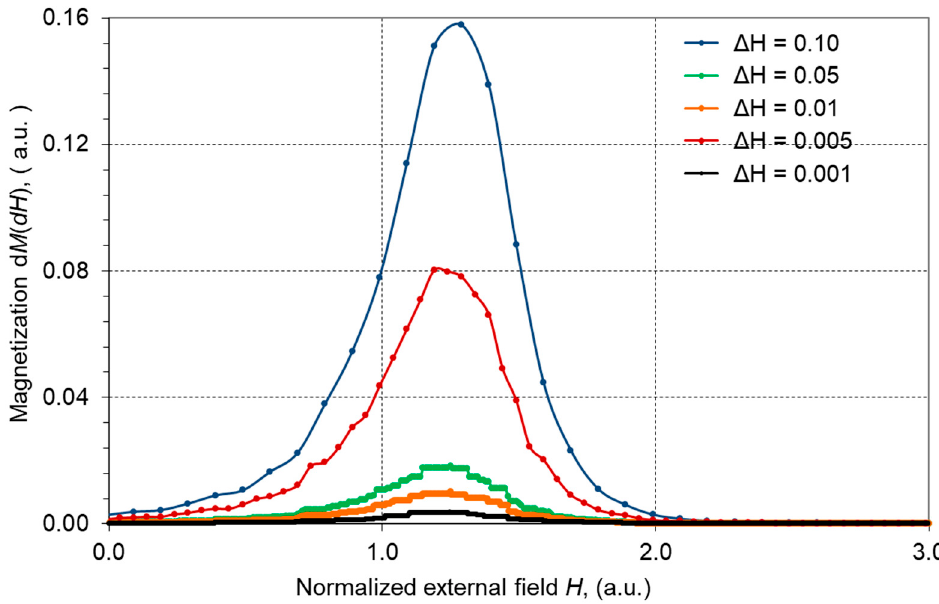
Figure 5. Dependence of dynamic changes in magnetization d M /d H of the model on the external field step Δ H ( D = 2, L = 5000, R = 2.00).